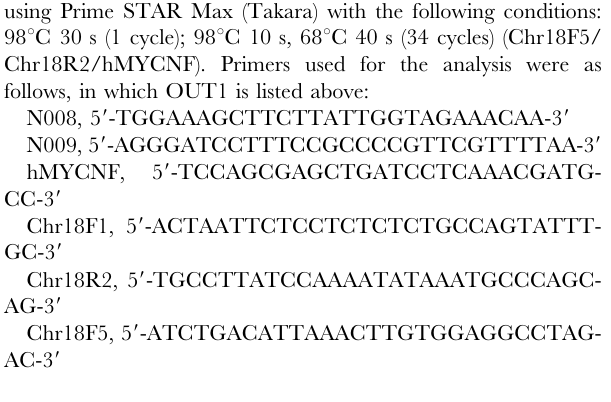
Fig. 1A. The probe used for this experiment corresponds to a 0.7 kb region of rabbit b -globin intron because both rat TH promoter and human MYCN gene have high homology compared with their mouse orthologs (more than 80%, data not shown).